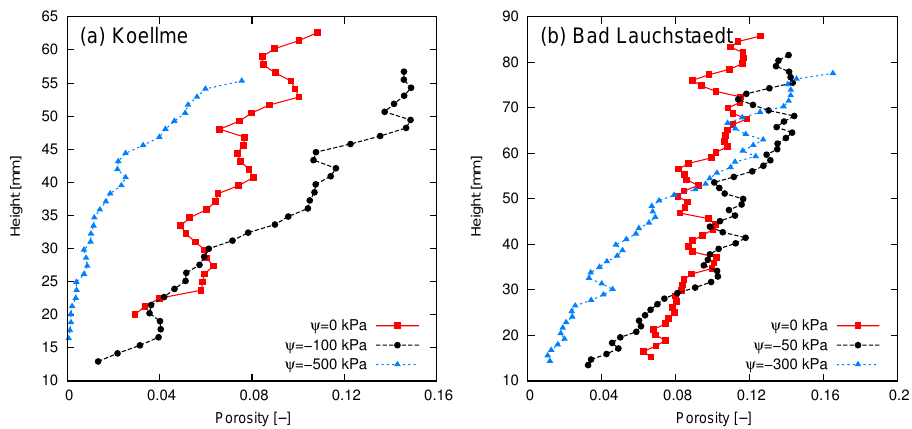
Figure 4. Depth profile of macroporosity ( > 61µm) at three different capillary pressures in the Köllme soil (a) and Bad Lauchstädt soil (b) . All images cover slightly different field of views and are normalized to a reference height at the bottom of the